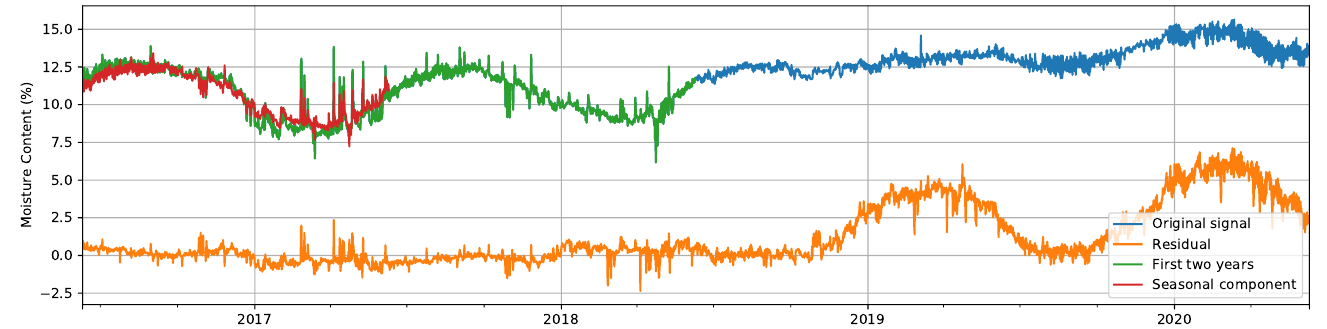
Figure 10. Comparison of the original signal (green and blue) and its seasonally-decomposed version (orange). The section of the original signal that was used to compute the seasonal component is presented in green, while the computed seasonal component is presented in